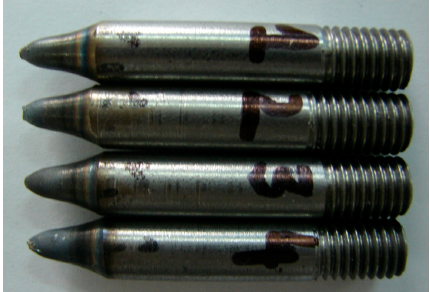
Figure 5. R200 steel specimens fractured in the tensile test performed with the Gleeble 3800 simulator at a temperature range of 1—900 °C (this temperature range was excluded from the fracture analysis since the plastometric test was constrained to the temperature range of 1000 °C–200 °C), 2—1000 °C, 3—1100 °C, and 4—1200 °C. Table 4. Dimensions of the tensile specimens used for determining damage function critical values (denoted in accordance with Figure 3).